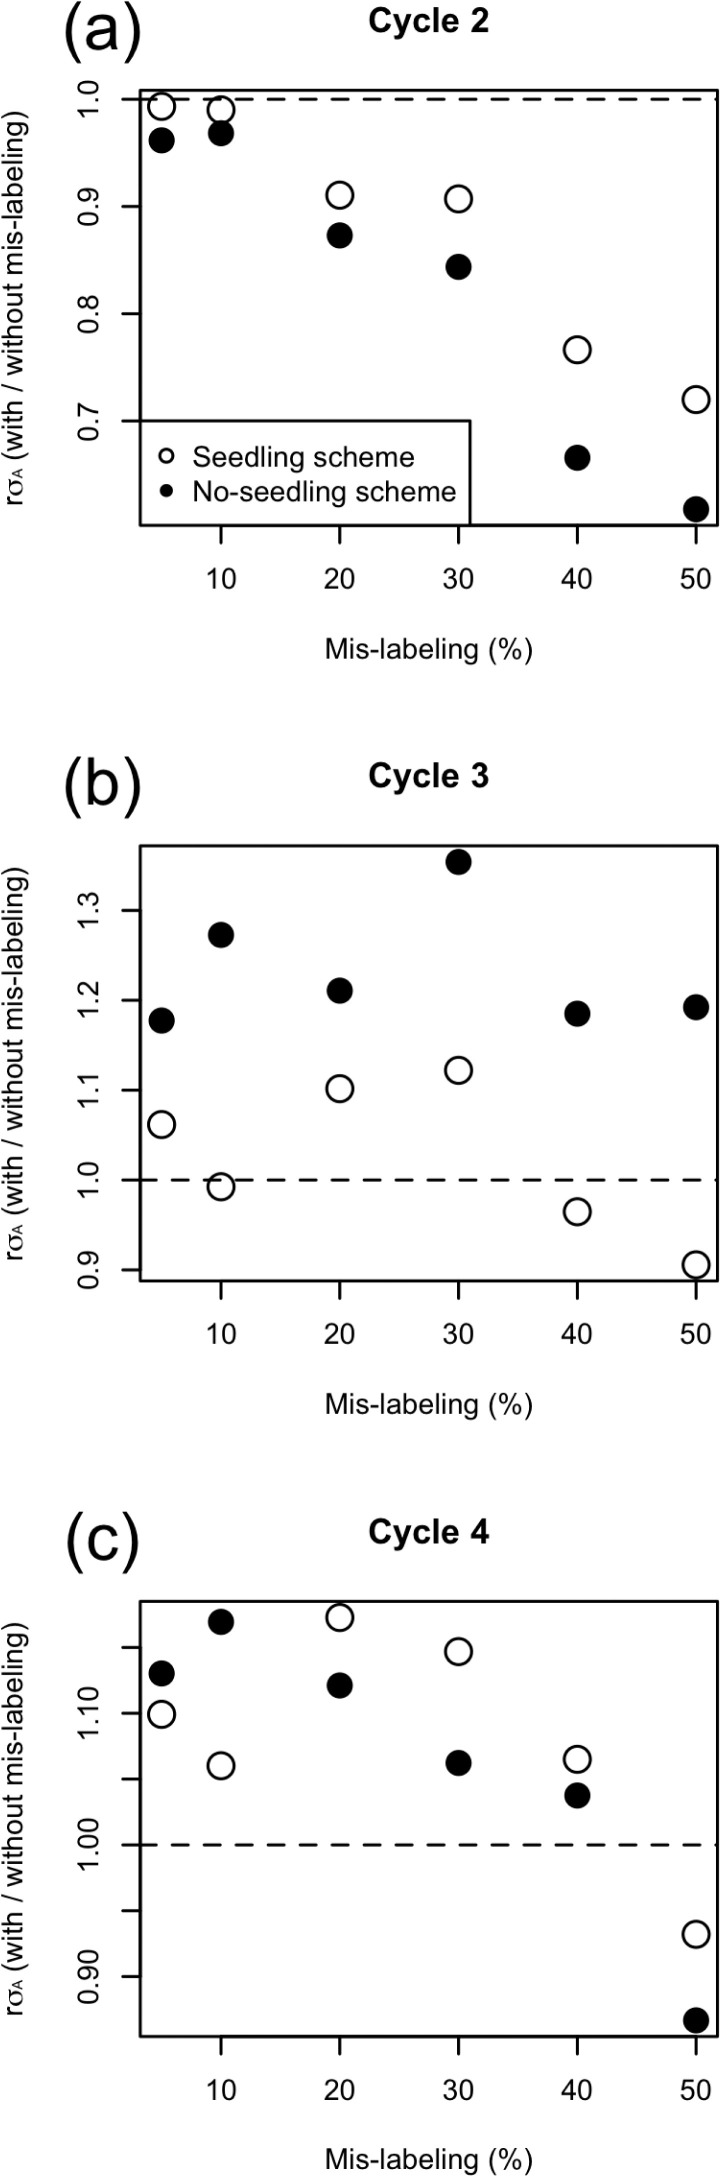
Relationship between the product of prediction accuracy and the square root of the additive genetic variance (rσA) in Eq. [5] and mislabeling from Cycle 2 to Cycle 4 with source errors at (a) Cycle 2, (b) Cycle 3, and (c) Cycle 4. The vertical axis represents the value of rσA with mislabeling as a fraction of that observed without mislabeling. Note that the scale of the y axis changes among figures.